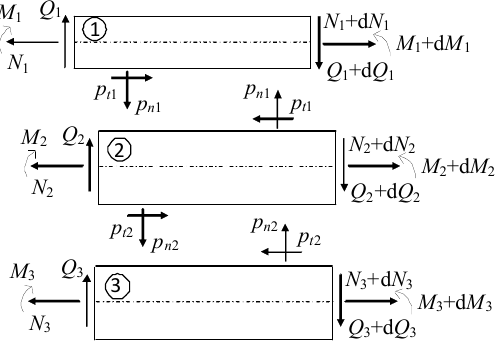
Figure 2. Composite beam assumed in the present model: Free-body diagram of an infinitesimal element.